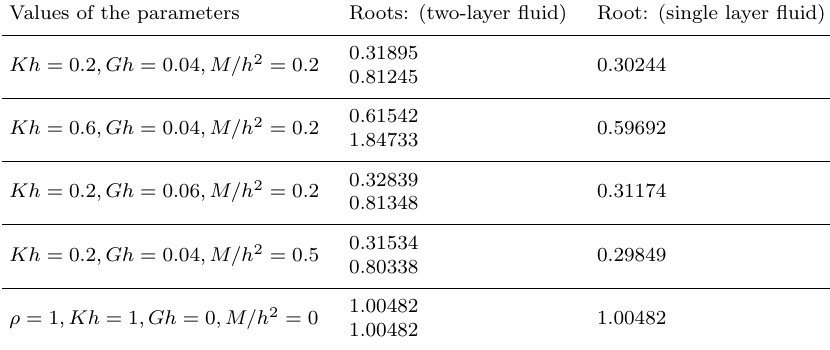
Table 1. Roots ( k ) of the dispersion relation (2.12) for different values of various parameters Values of the parameters Roots: (two-layer fluid) Root: (single layer fluid) 0.31895 0.30244 Kh = 0 . 2 ,Gh = 0 . 04 ,M/h 2 = 0 . 2 0.81245 Kh = 0 . 6 ,Gh = 0 . 04 ,M/h 2 = 0 . 2